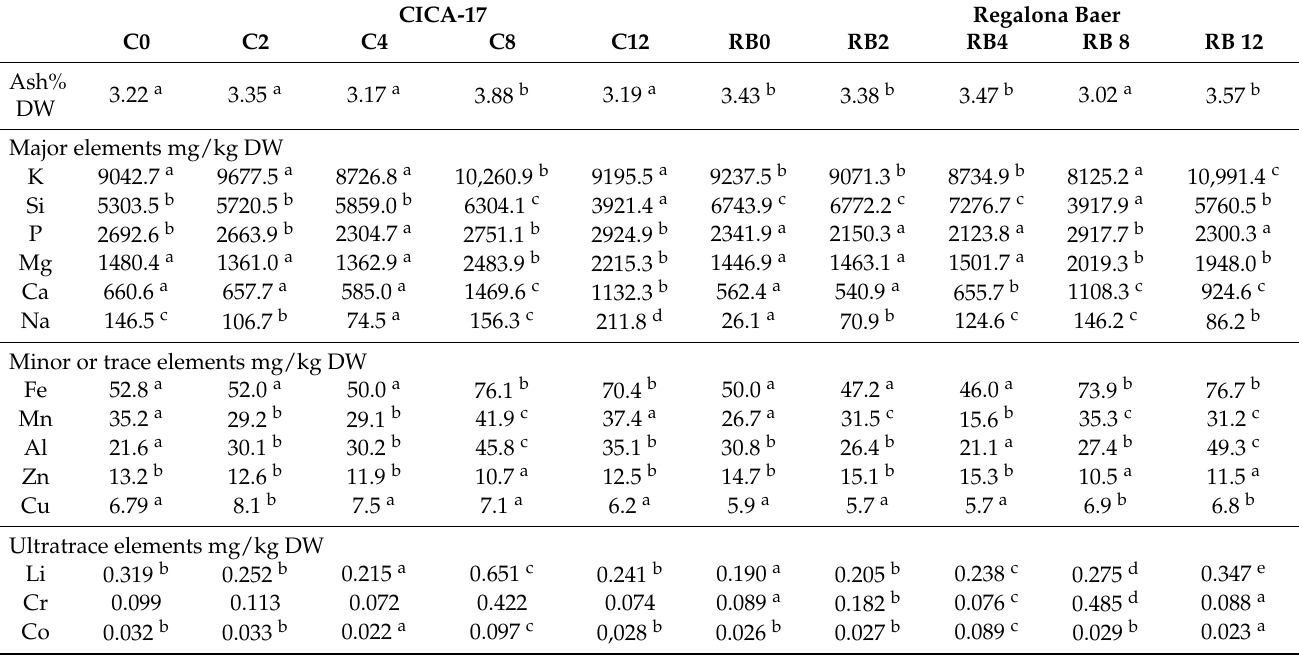
Table 5. Ash and mineral content in CICA-17 and RB varieties under different manure